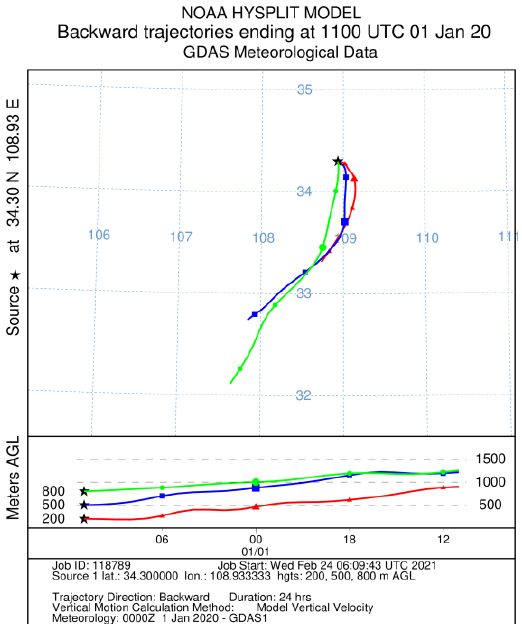
Figure 13. The backward trajectories of aerosols from HYSPLIT at the measurement site.